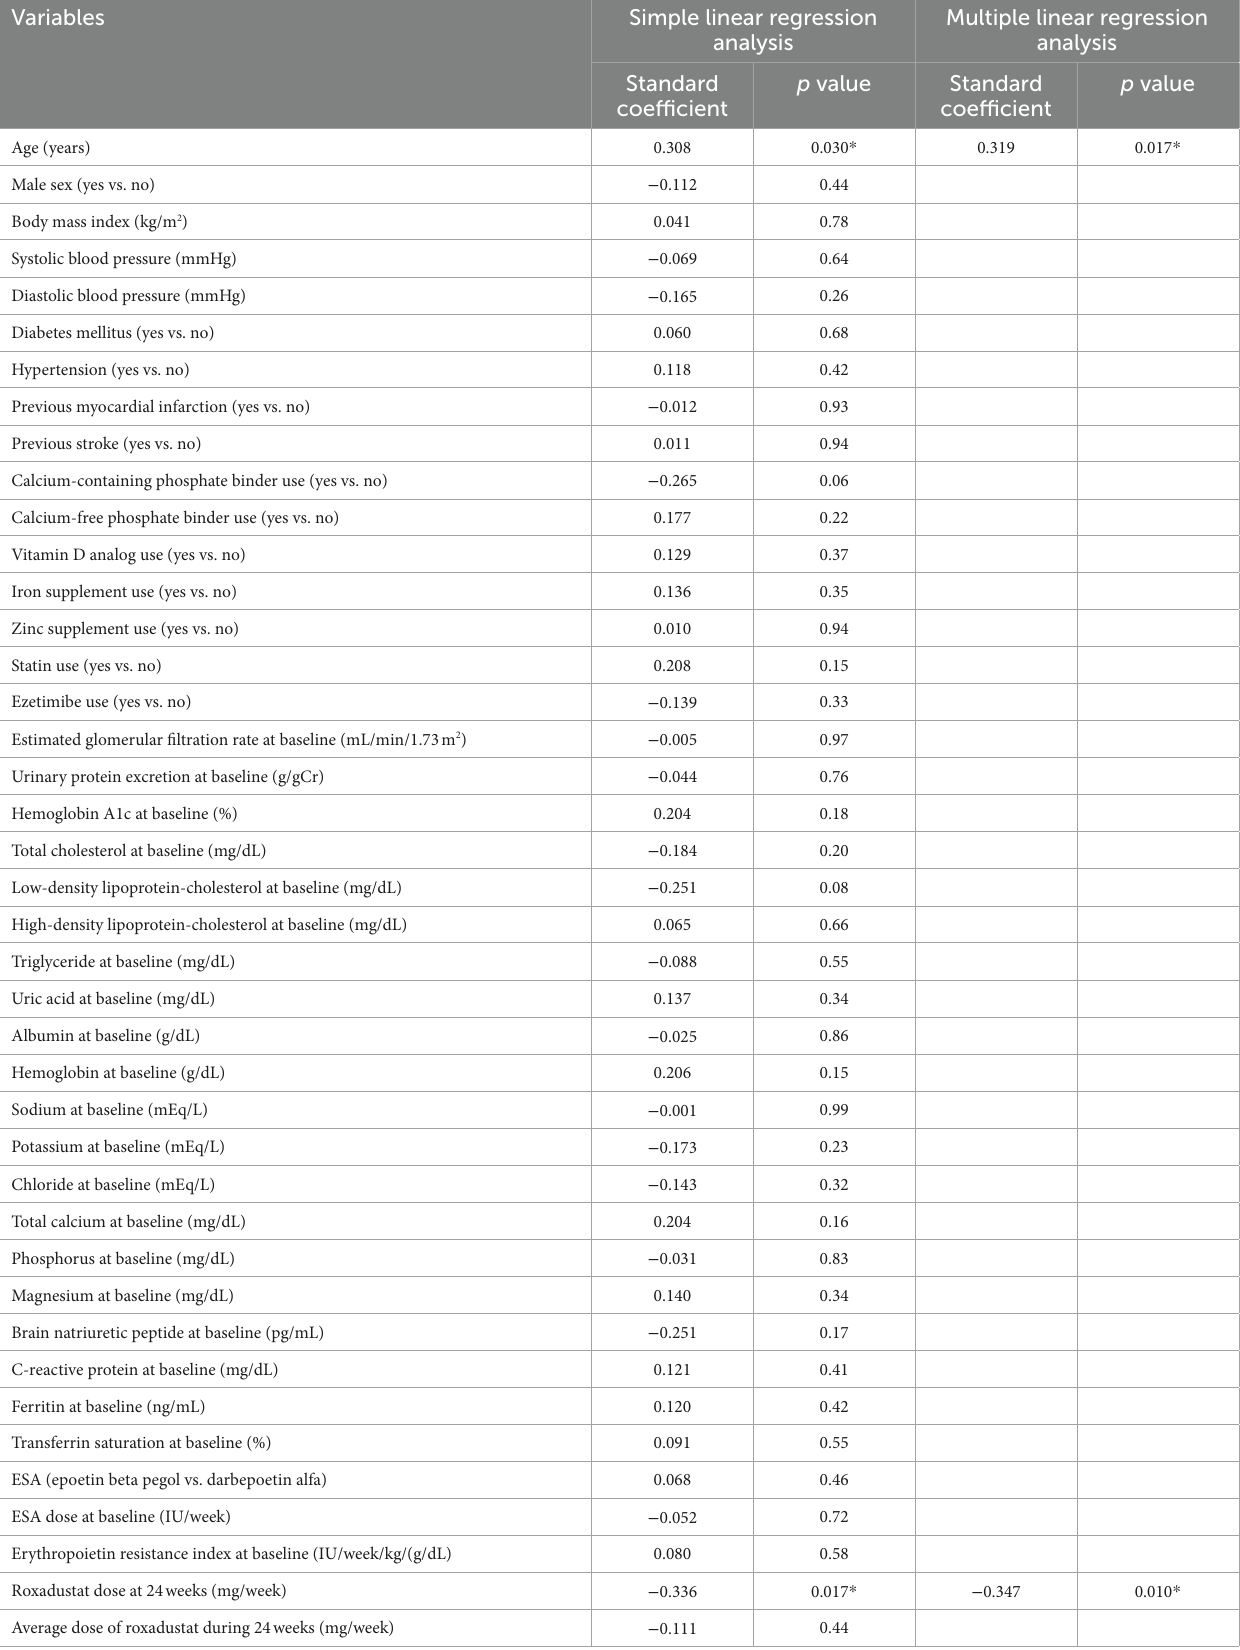
TABLE 3 Simple and multiple linear regression analyses of the variables correlated with hemoglobin concentration after 24 weeks of roxadustat administration.